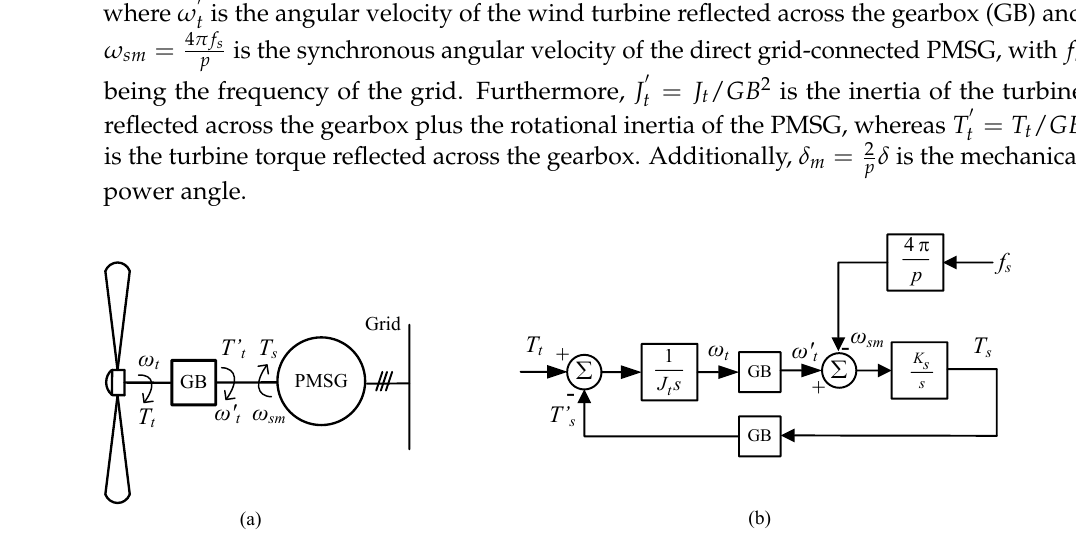
Figure 1. Simplified ( a ) line diagram representation model and ( b ) block diagram model of a direct grid-connected, geared PMSG